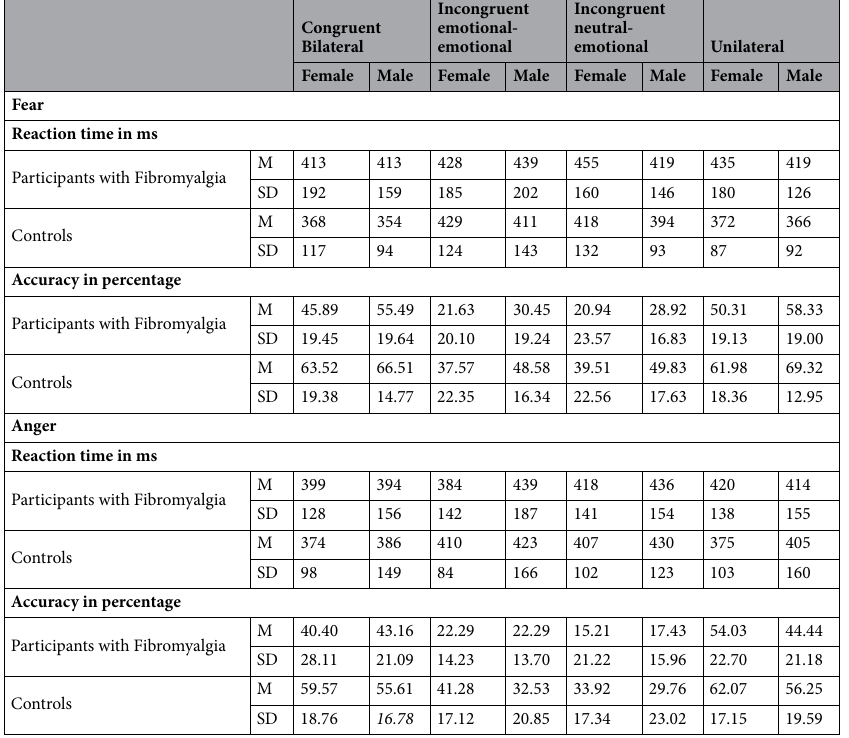
Table 2. Mean (M) and standard deviation (SD) for each experimental condition (congruent bilateral, incongruent emotional-emotional, incongruent neutral-emotional, unilateral) split for the visual stimuli gender (female vs male), relative to the two groups (participants with fibromyalgia vs controls) are reported about the reaction time (expressed in milliseconds) and the level of accuracy (expressed in percentage). The upper part regards the emotion of fear; the lower part, the emotion of